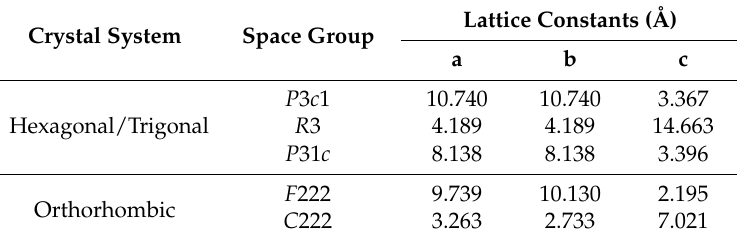
Table 3. Possible crystal structure of the Ni 2 AlLa intermetallic compound.